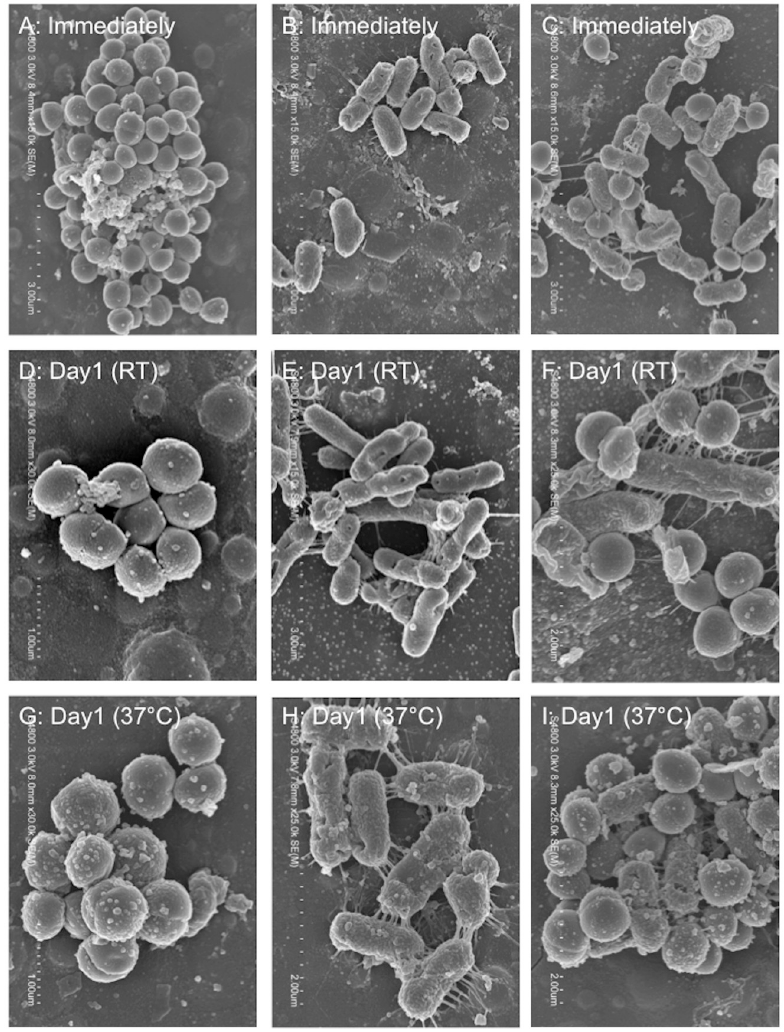
Fig 2. Representative SEM images showing bacterial morphologies on vinyl chloride surfaces. E . coli alone (A, D, G). S . aureus alone (B, E, H). Mixture of E . coli with S . aureus (C, F, I). Scale bars in panels, 1 μ m (D, G), 2 μ m (F, H, I) and 3 μ m (A, B, C, E). RT, room